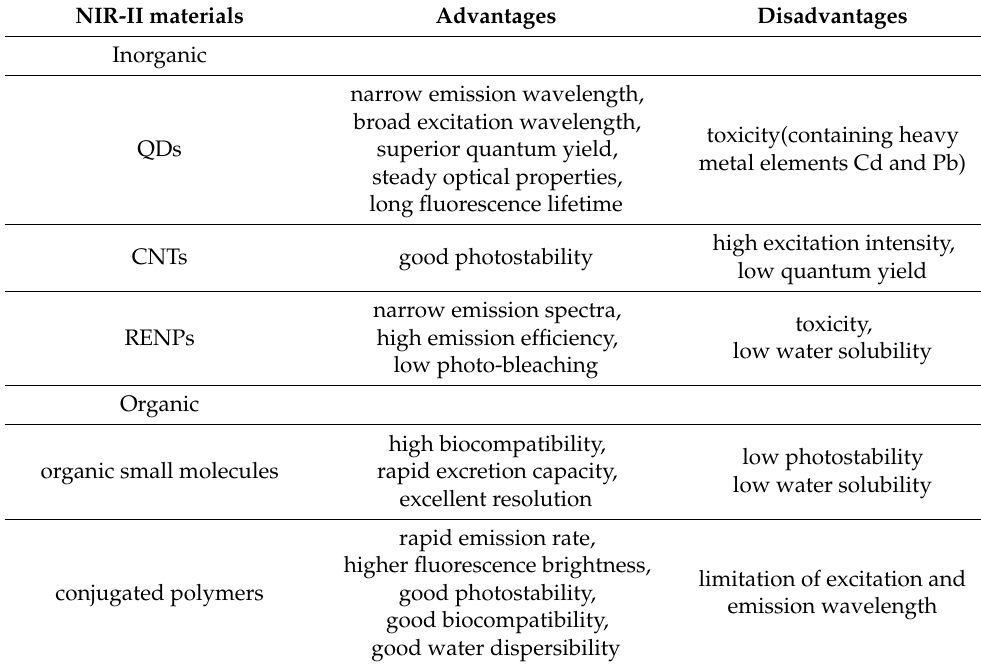
Table 1. The summary of the advantages and disadvantages of NIR-II